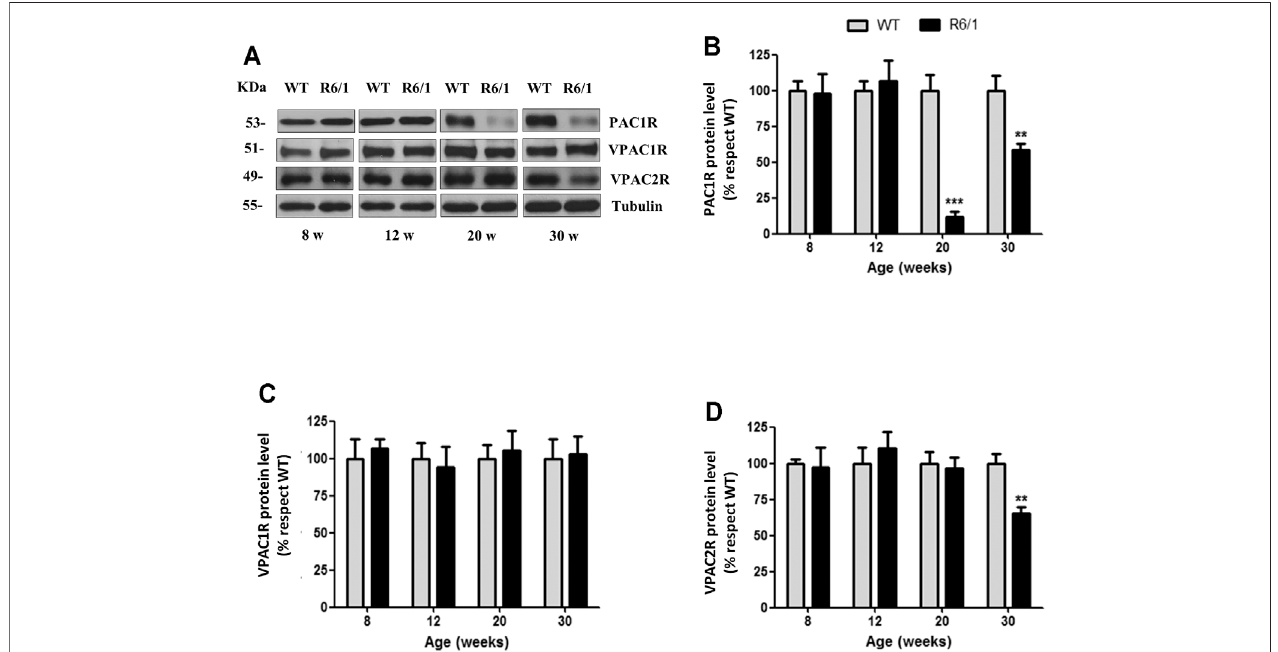
FIGURE 8 | PAC1R is decreased in the striatum of R6/1 mice from week 20. Protein levels of PAC1R, VPAC1R, and VPAC2R were analyzed in striatal samples of WT and R6/1 mice at different ages by Western blot. (A) Representative immunoblots are shown. Quanti fi cation of (B) PAC1R, (C) VPAC1R, and (D) VPAC2R was performed. Results (mean ± SEM; n (cid:1) 7) were normalized to the loading control tubulin and are expressed as a percentage respect to WT mice. Statistical analysis was performed using unpaired Student ’ s t-test. ** p < 0.01 and *** p < 0.001 as compared to WT mice.